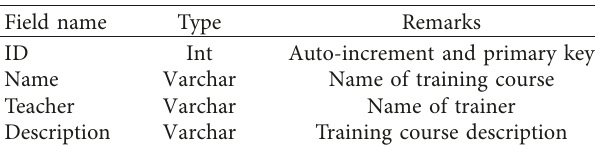
Table 2: Course schedule.